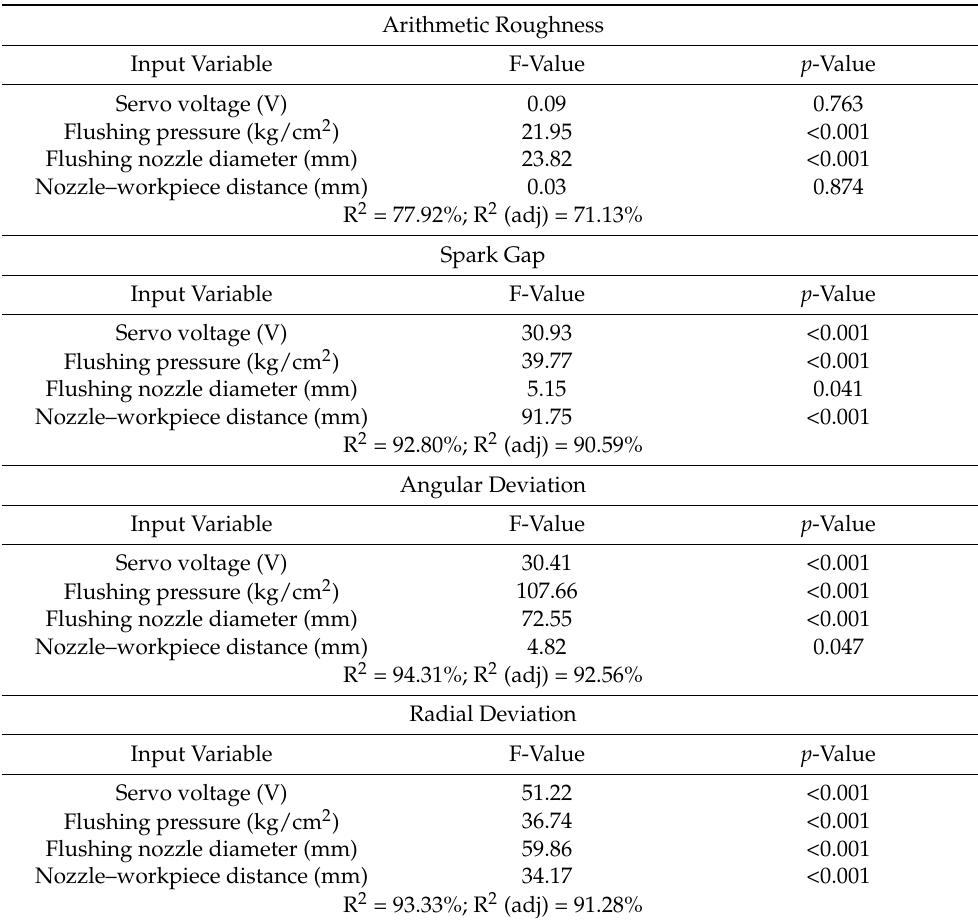
Table 4. Parametric significance analysis through